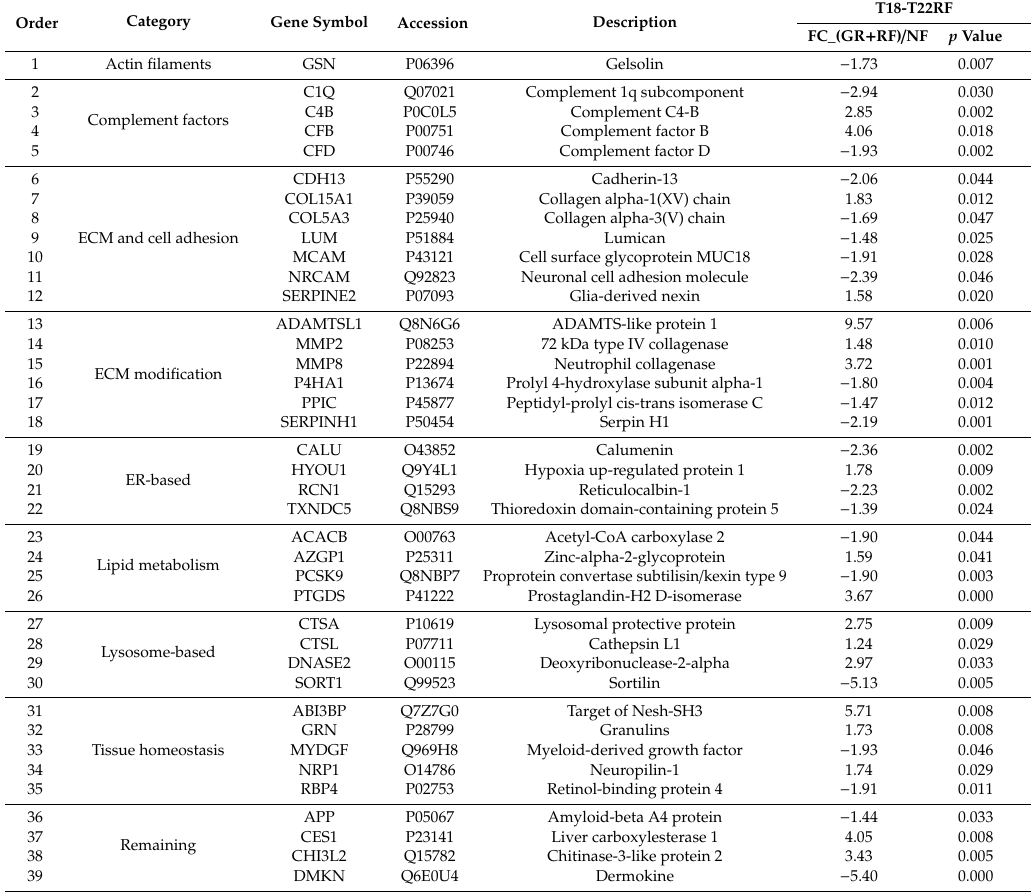
Table 3. Proteins significantly di ff erent between GR plus RF and